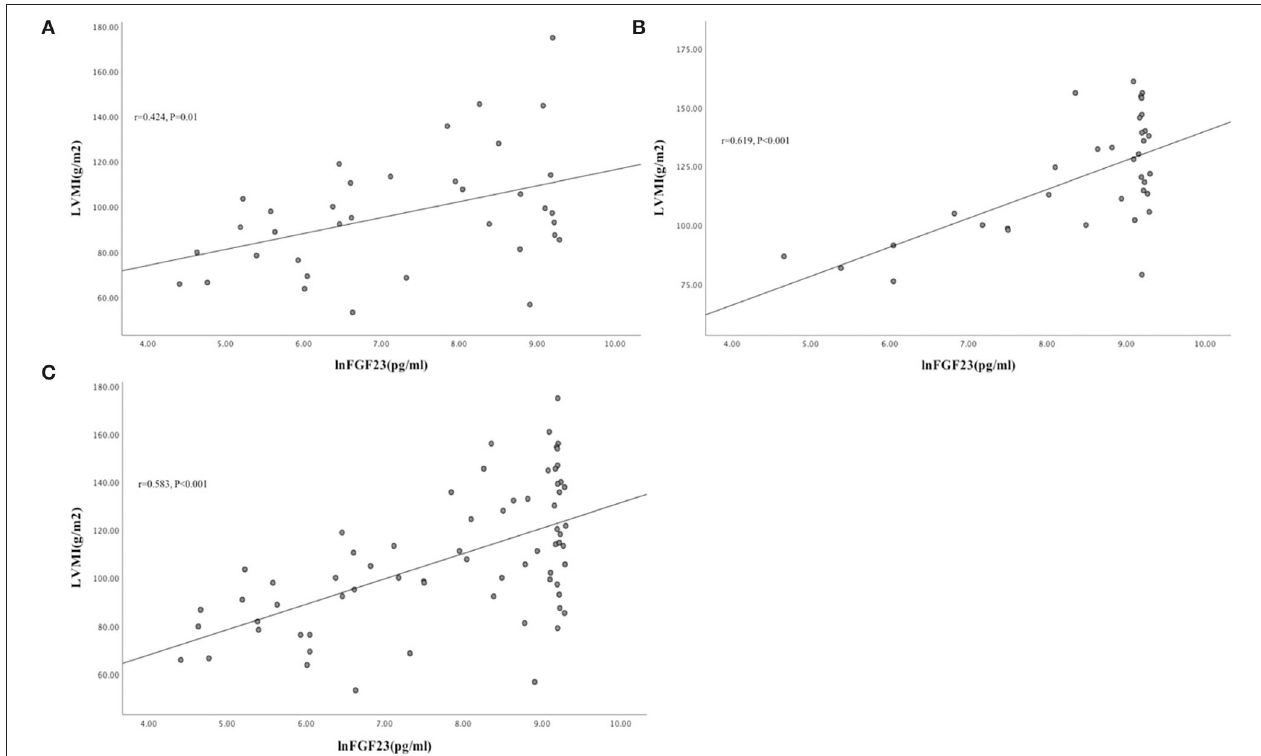
FIGURE 2 | Univariate linear correlation between lnFGF23 and LVMI in INHD group (A) , CHD group (B) , and within overall patients (C) ( Figure 3 ).